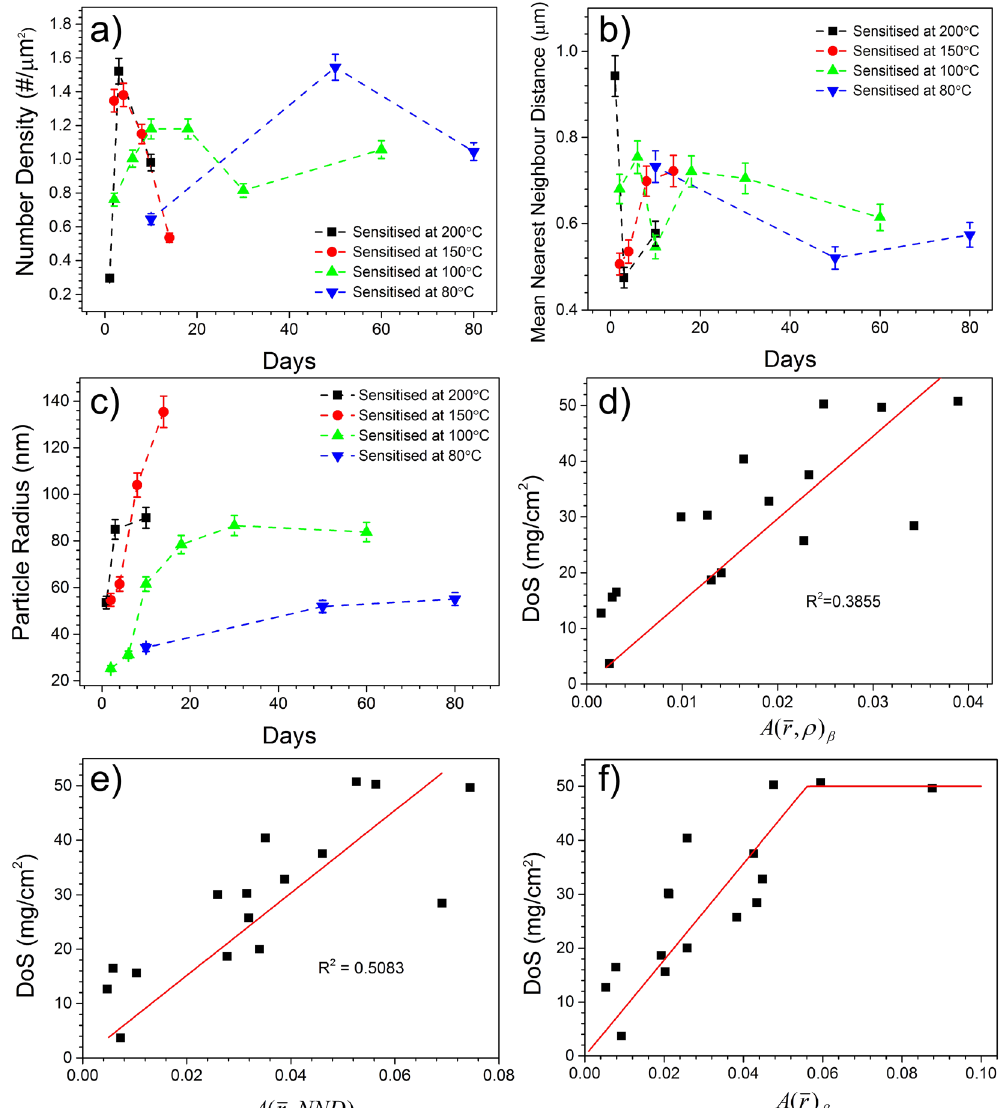
Figure 5. Summary of grain boundary statistics related to β -phase from sensitised AA5083 which was analysed via HR-SEM of Ga-embrittled fracture surfaces. ( a ) Number density of β phase vs. sensitisation time; ( b ) inter- β -phase particle spacing vs. sensitisation time; ( c ) equivalent radius of β vs. sensitisation time; ( d ) DoS (NAMLT values). vs. the areal coverage fraction of β -phase on the grain boundaries ρ β A (r, ) ; ( e ) DoS vs. the areal coverage fraction along the path of greatest particle continuity β A NND (r, ) ; ( f ) DoS vs. the areal coverage fraction assuming a material characteristic NND, β A (r)